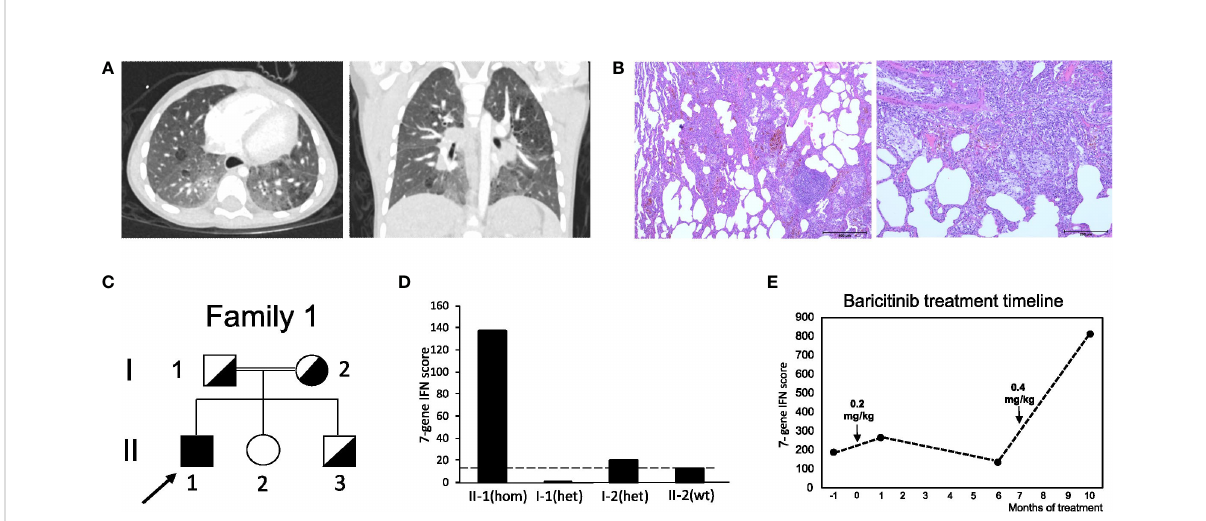
FIGURE 1 Clinical features and pedigree of patient 1. (A) Chest CT at the age of fi ve years, displaying milk glass opacities, cystic lesions and architectural distortion consistent with interstitial fi brosis. (B) Lung biopsy displaying interstitial hemorrhage. (C) Pedigree of patient 1 ’ s family; fi lled symbol: homozygosity; half- fi lled symbol, heterozygosity; clear symbol: wild type; arrow indicates patient 1 (II-1). (D) IFN score from whole blood for the patient with c.841C>T p.(Arg281Trp) homozygosity (hom) after receiving baricitinib treatment at month 6 and his healthy family members carrying the variant in heterozygosity (het) or wild type (wt) STING1 alleles; dash line indicates threshold of 12.49 from healthy controls. (E) IFN score changes in patient 1 before and after baricitinib treatment. Patient started to receive baricitinib treatment at month 0 and dosage was increased at month